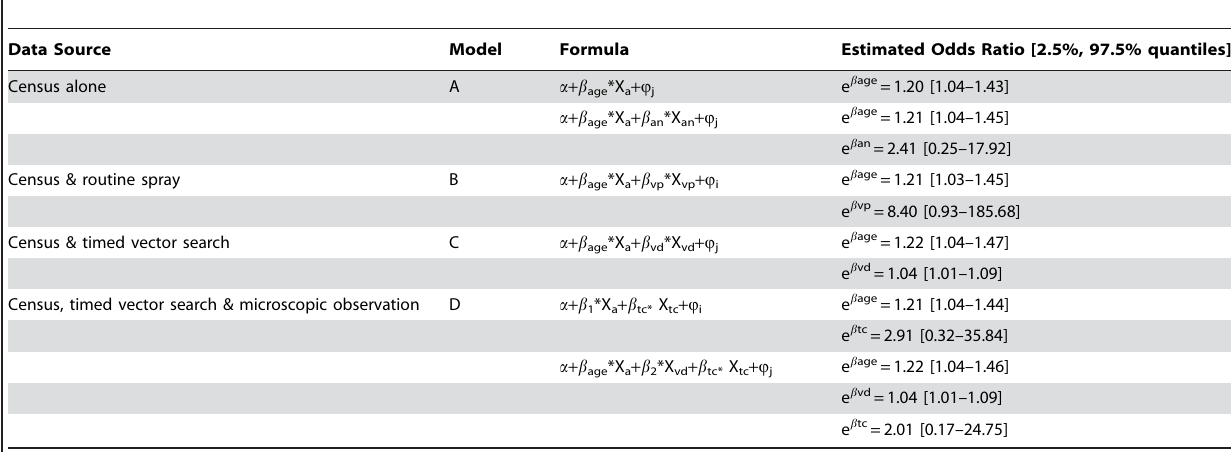
Table 2. Fit multivariate models predicting T. cruzi infection in children 18 years and younger in the community of Guadalupe, Arequipa, Peru, 2005